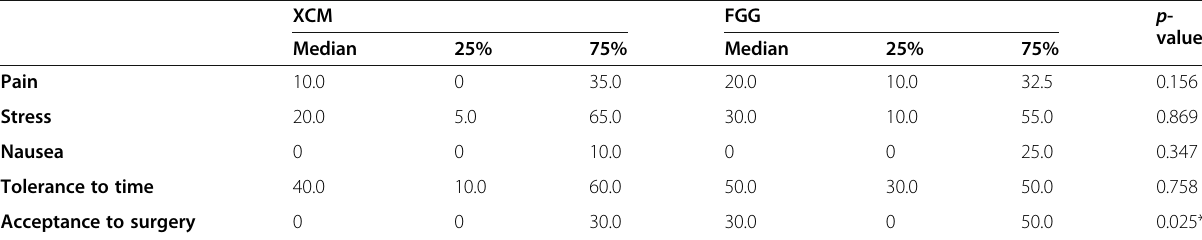
Table 2 PROMs during the operation